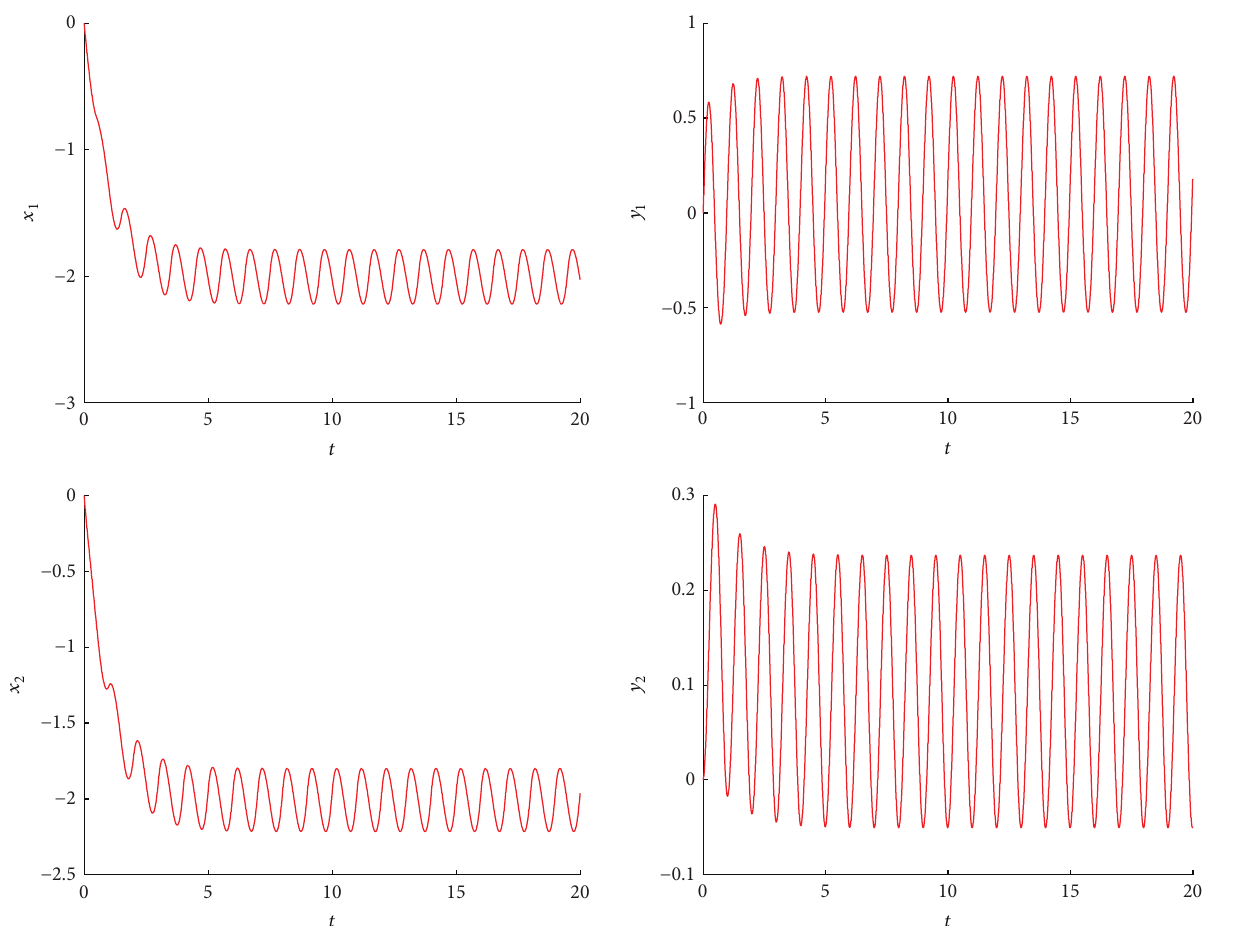
Figure 1: Transient states of the real and imaginary parts of system